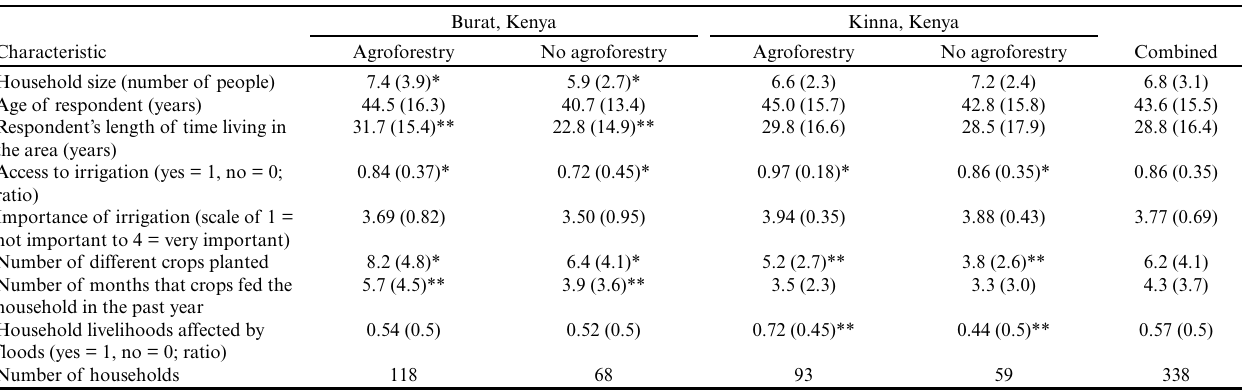
Table 2. Summary of household characteristics (mean and standard deviation). Burat, Kenya Kinna, Kenya